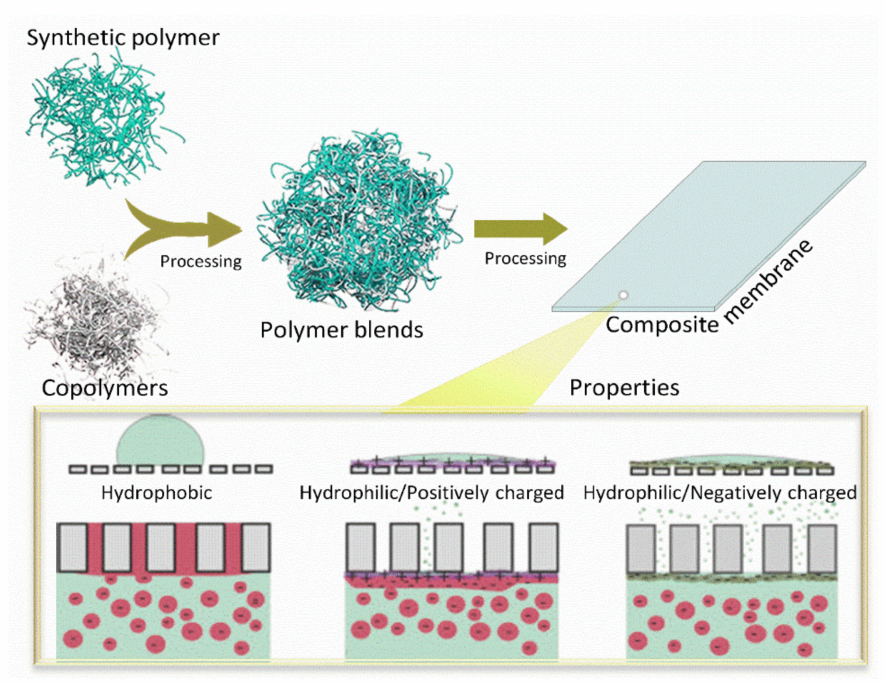
Figure 6. Schematic illustration of the preparation of PPSU membrane with superior properties via a typical polymer and copolymer blend